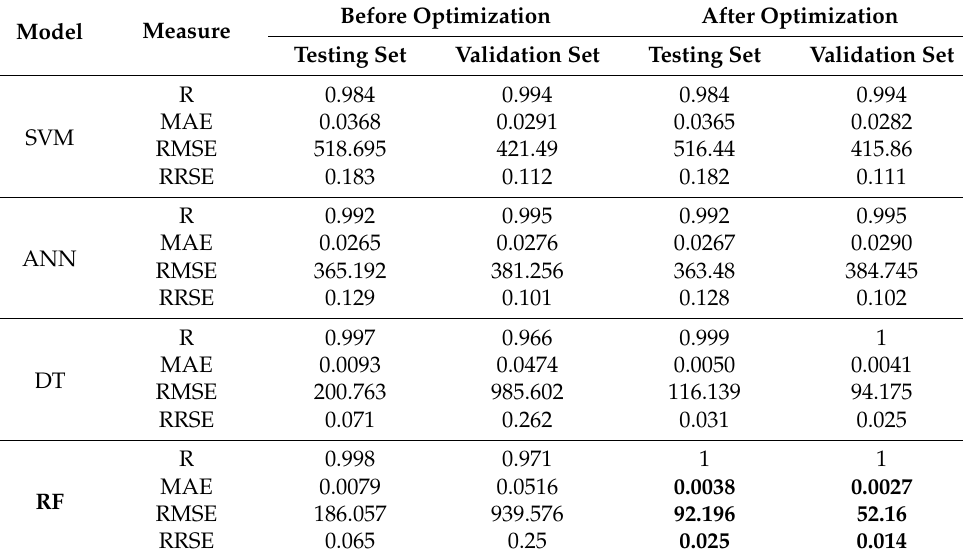
Table 4. Performance results of the four Table 3. Parameter tuning results.